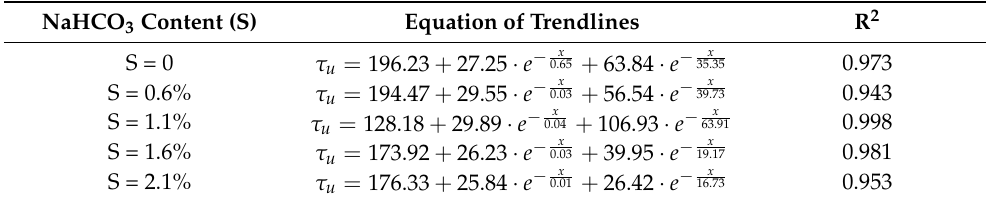
Table 4. Equation of trendlines of shear strength versus the number of FTCs at a confining pressure of 100 kPa.